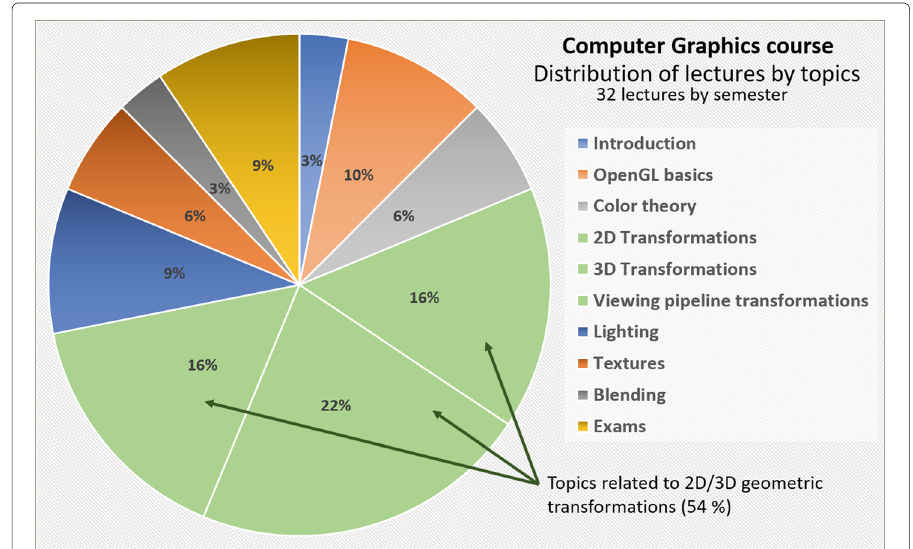
Fig. 4 Distribution of topics by lectures in the Computer Graphics